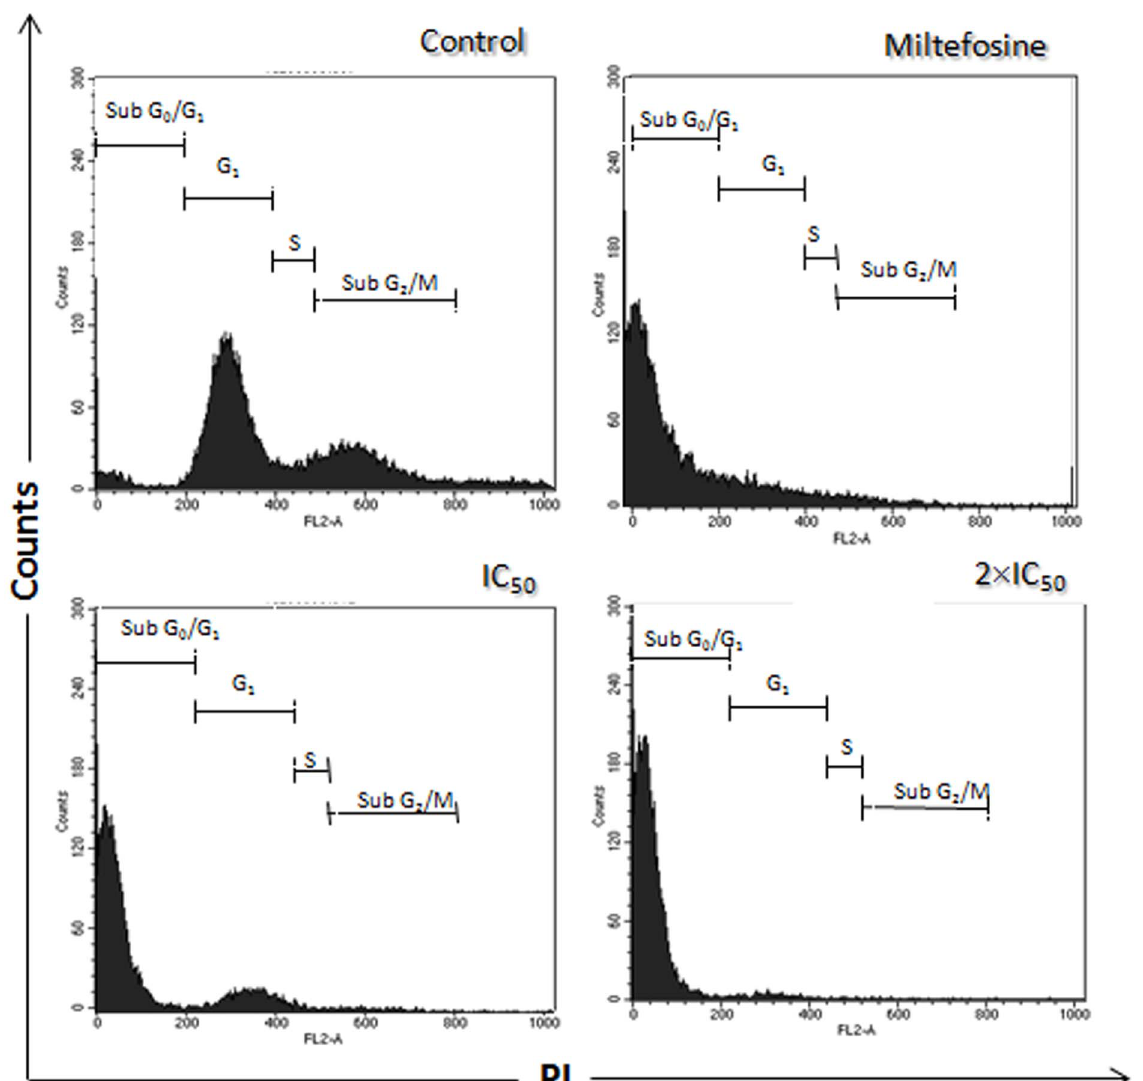
Figure 5. Increase in the sub G 0 /G 1 DNA-containing Leishmaniaamazonensis promastigotes population after MDL28170 treatment. The DNA content degradation profiles of exponential-phase promastigotes of Leishmania amazonensis treated or not with MDL28170 (IC 50 and two times the IC 50 [2 6 IC 50 ] doses) were assessed by flow cytometry after cell permeabilization and PI staining. DNA fragmentation was quantified by measuring the cell population in the sub G 0 /G 1 DNA region. Cells treated with miltefosine (40 m M for 24 h) were used as